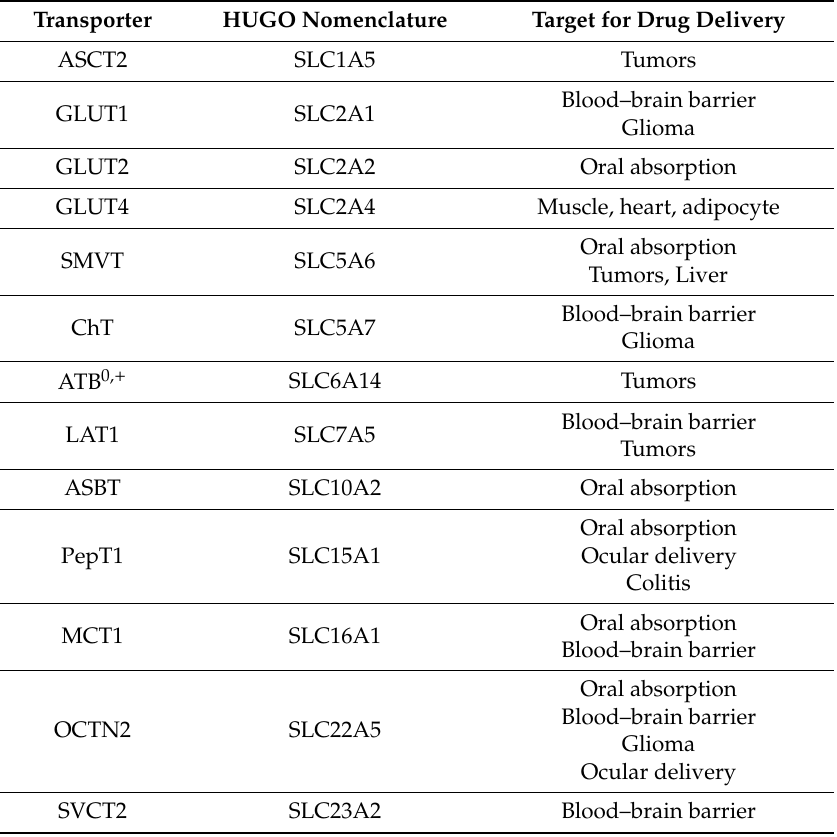
Table 1. Plasma membrane transporters that have been evaluated for targeted drug delivery in the form of